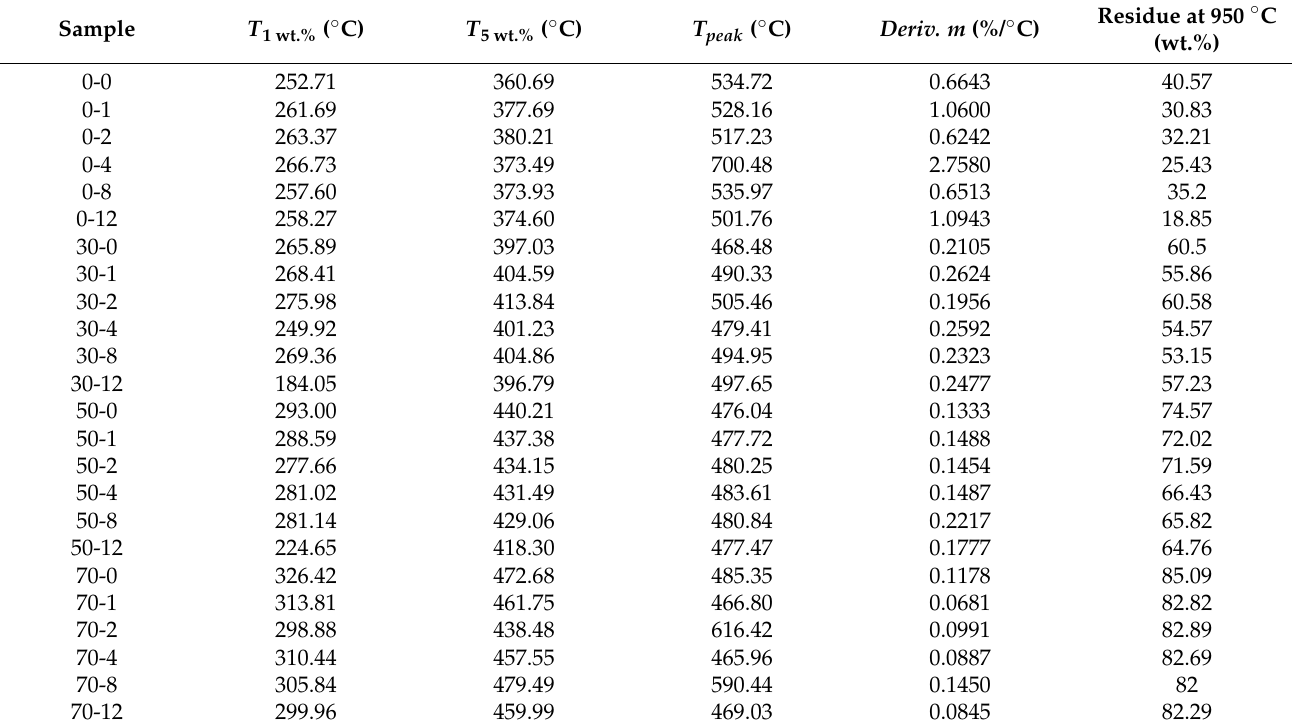
Table 3. Phenomenological data of the thermal decomposition of a clear PDMS and PDMS-MPs-based composites.